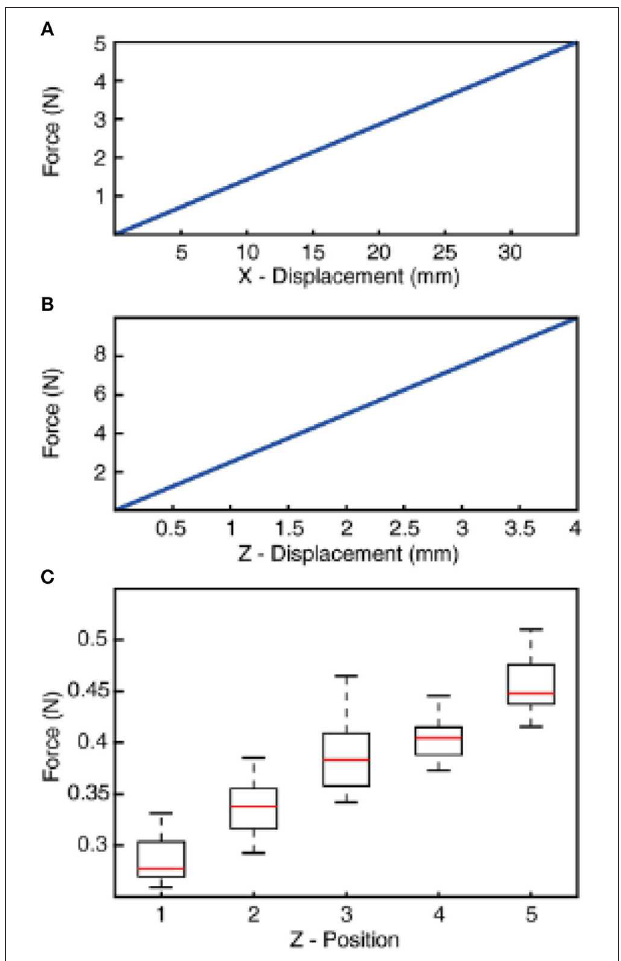
FIGURE 3 | Normal and shear stiffness of the compliant wrist and resulting sensing force between the tactile sensor and stimuli. (A) Tangential stiffness (across x-axis) of the compliant wrist displacement as the function of applied force. (B) Compressive stiffness (across z-axis) of the compliant wrist displacement as the function of applied force. (C) Sensing forces recorded during finger contact with all stimuli (1–9) associated to the different z-axis positions of the robot (Z-positions 1–5). The z-positions are obtained with a progressive increase by a step of 0.5mm toward the stimuli from home position (as described in Methods). The boxplot illustrates the range of force across 5 mechanical repetitions and all 9 stimuli. The forces are recorded using a loadcell that is placed between the compliant wrist and the robotic arm.